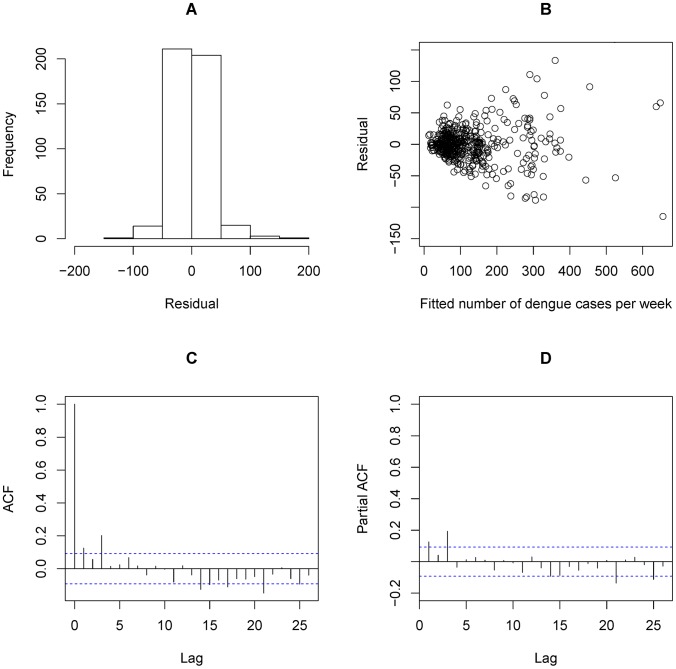
Residual analysis for DLNM-MeanT model.A: Residual histogram; B: Residual v.s. Number of dengue cases per week; C: Residual autocorrelation function; D: Residual partial autocorrelation function.